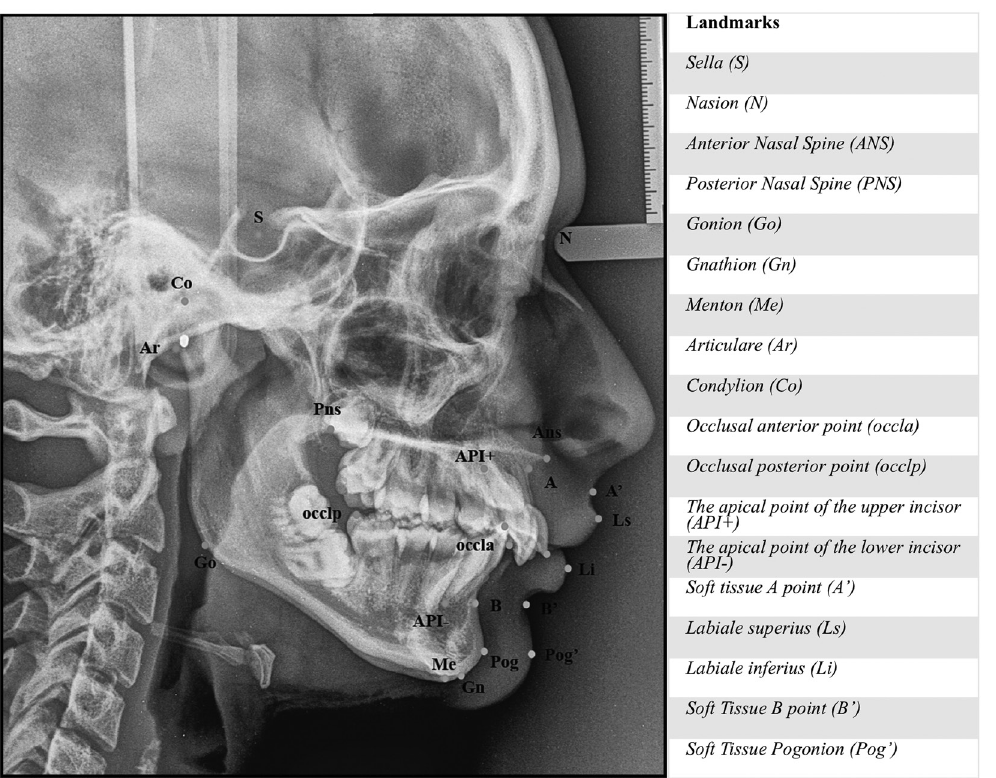
occlusion, with adequate visualisation of reference structures, and without appreciable head rotation. All of the lateral radiographs were taken by the same technician and on the same machine in the same radiology